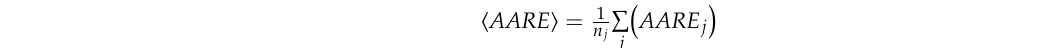
Table 4. Mean squared deviation (%) in the time-averaged predicted radial solids holdup profiles for spouted bed packed with 1 mm glass beads, H σ ,0 = 160 mm and